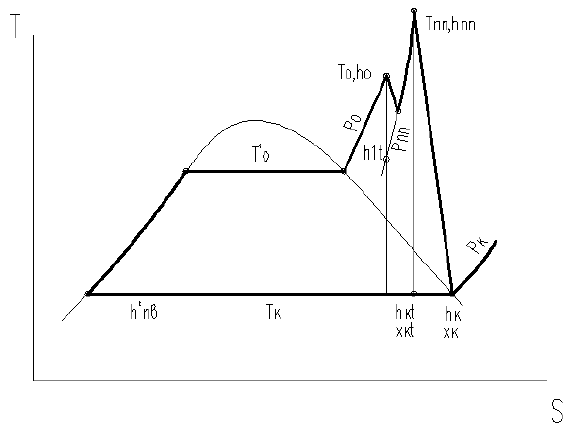
Figure 6. H-S diagram of the steam expansion process in a turbine with an increase in temperature after intermediate overheating.